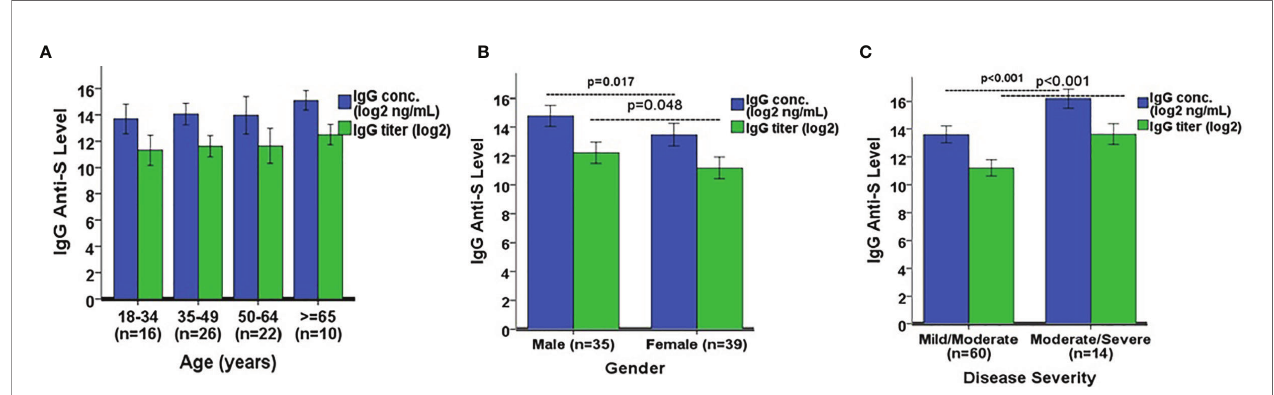
FIGURE 5 | Comparison of IgG anti-S geometric mean levels by (A) age, (B) gender, and (C) disease severity. A one-way ANOVA was used for the statistical analysis of mean differences between age comparison, and an independent Student ’ s t test was employed for mean differences in gender and disease severity. A total of 74 SARS-CoV-2 PCR positive sera was analyzed in the comparison. Error bars represent standard deviations.